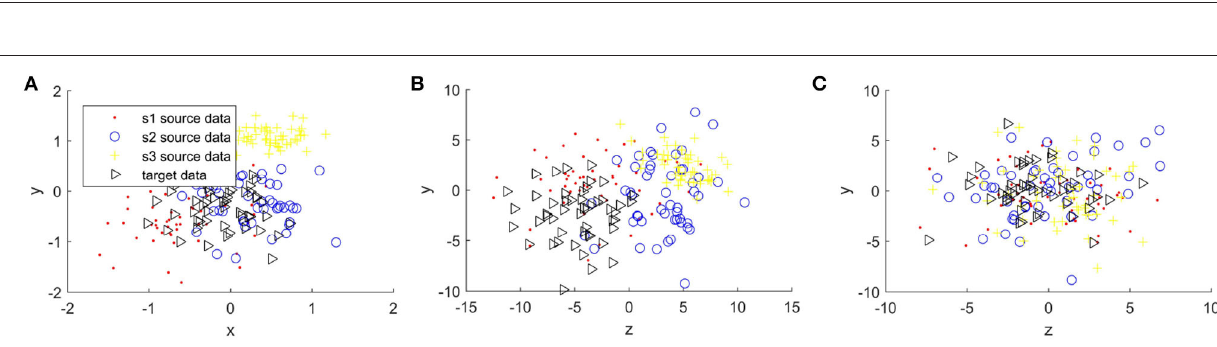
Frontiers in Neuroscience | www.frontiersin.org 9 May 2022 | Volume 16 | Article